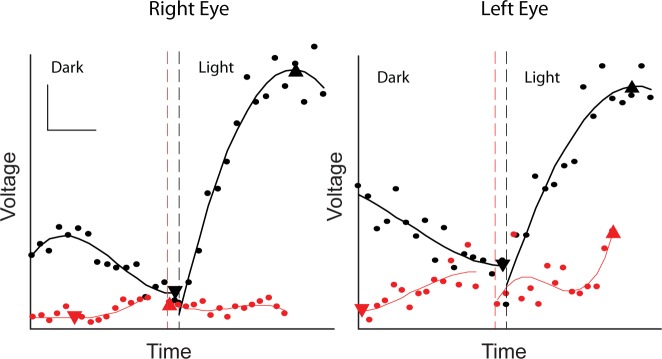
Reduced EOG light peak in patient with BEST1 I201T mutation.The EOG of BEST1 I201T patient (red) was compared to that of a similarly aged BEST1 WT person (black). Scale bar, 2 μV/deg, 5 min.